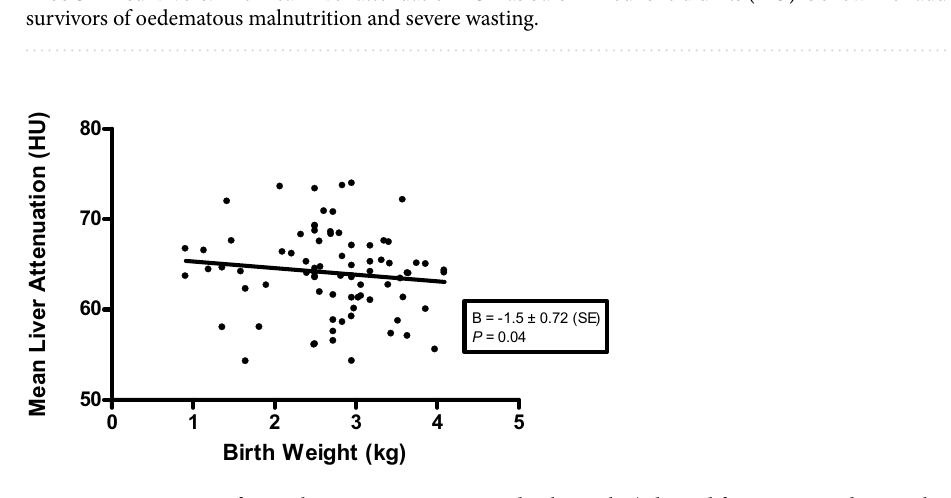
Figure 2. Regression of mean liver attenuation against birth weight (adjusted for age, sex and SAM phenotype) in 88 SAM